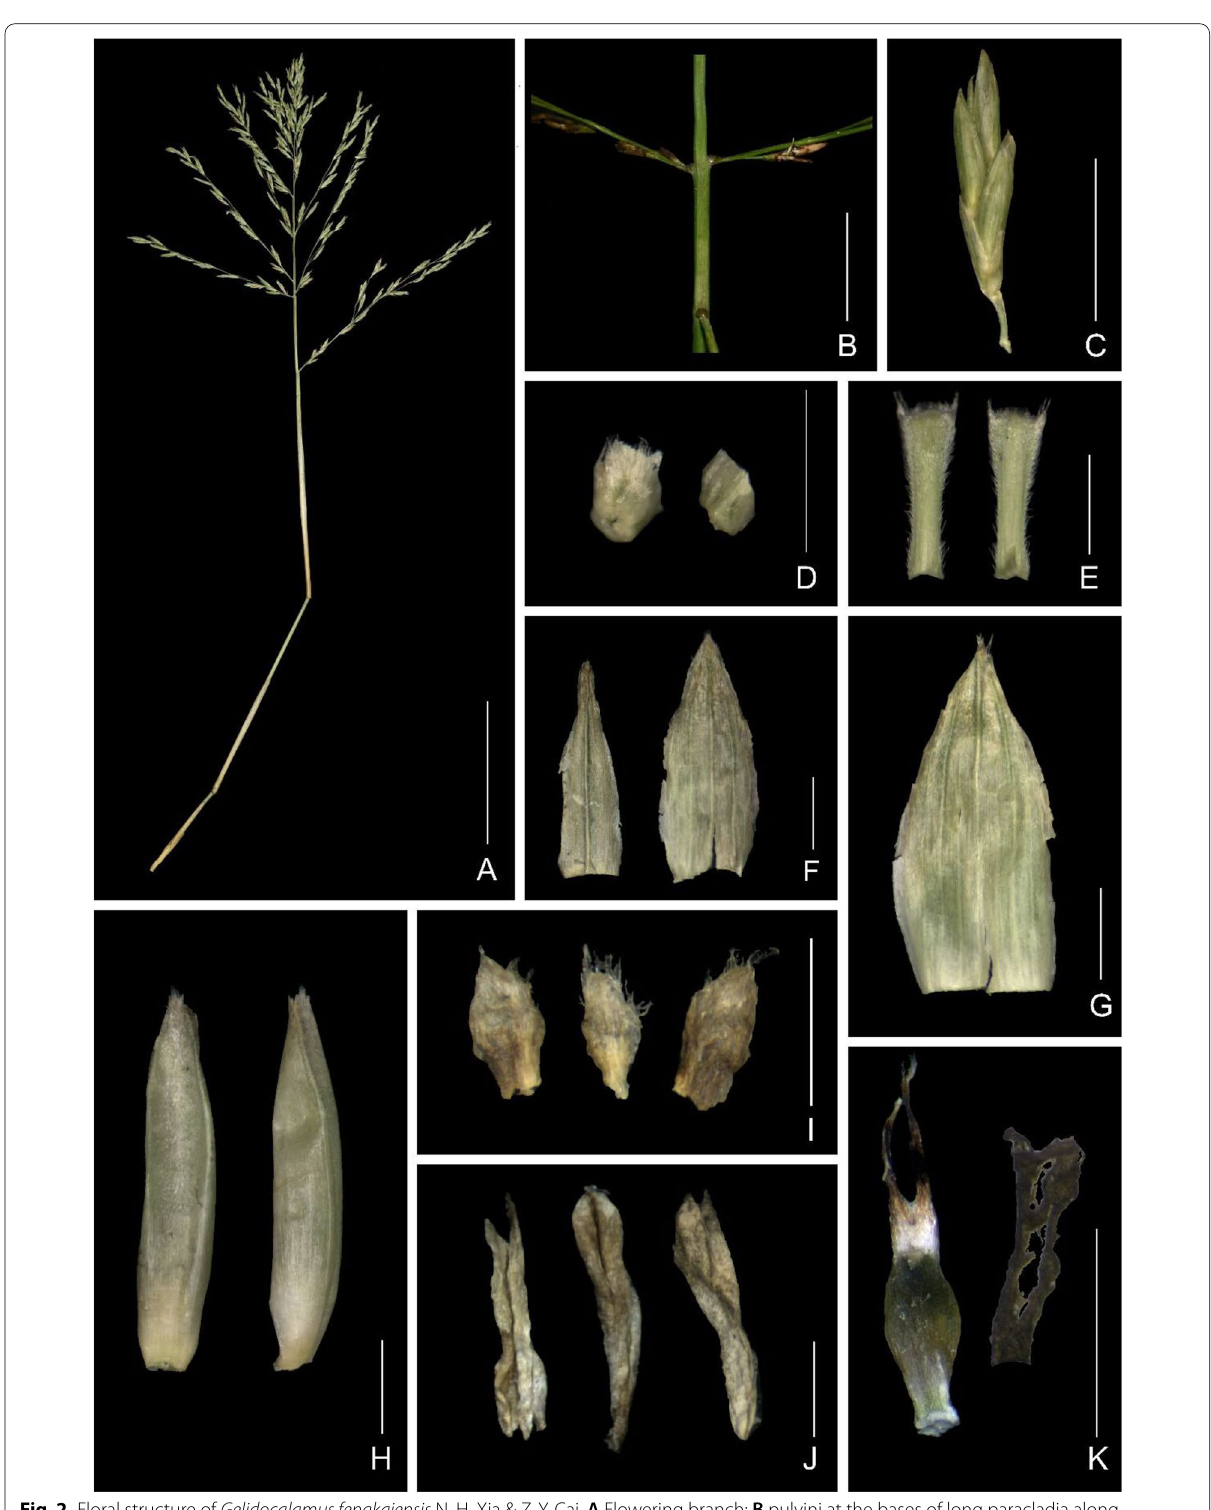
Fig. 2 Floral structure of Gelidocalamus fengkaiensis N. H. Xia & Z. Y. Cai. A Flowering branch; B pulvini at the bases of long paracladia along inflorescence main axis; C spikelet; D callus, adaxial (left) and abaxial (right) view; E rachilla segment, adaxial (left) and abaxial (right) view; F first glume (left) and second glume (right); G lemma; H palea, adaxial (left) and side (right) view; I lodicules; J stamens; K ovary with styles (left) and stigmas with a part of style (right). Scale bar: A and C 5 mm; B and D – K 1